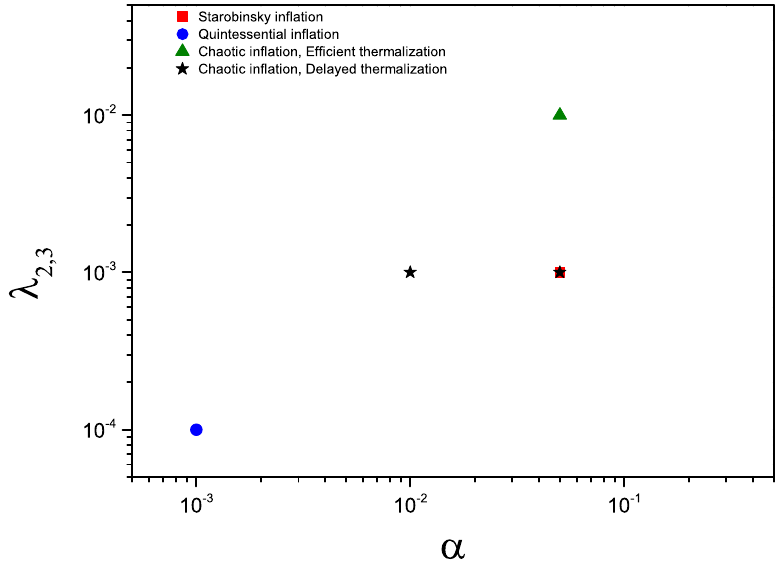
Figure 1. The figure presents different inflationary models in the α − λ 2,3 plane for which successful SFC baryogenesis is achieved for the following parameters: λ 1 = 5 × 10 − 2 , m = 350 GeV and H I = 10 12